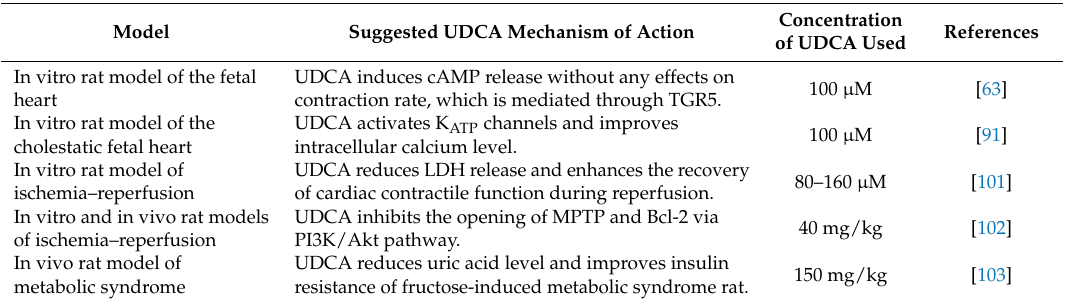
Table 2. The summary of UDCA mechanisms of action with the experimental models/subjects and concentrations